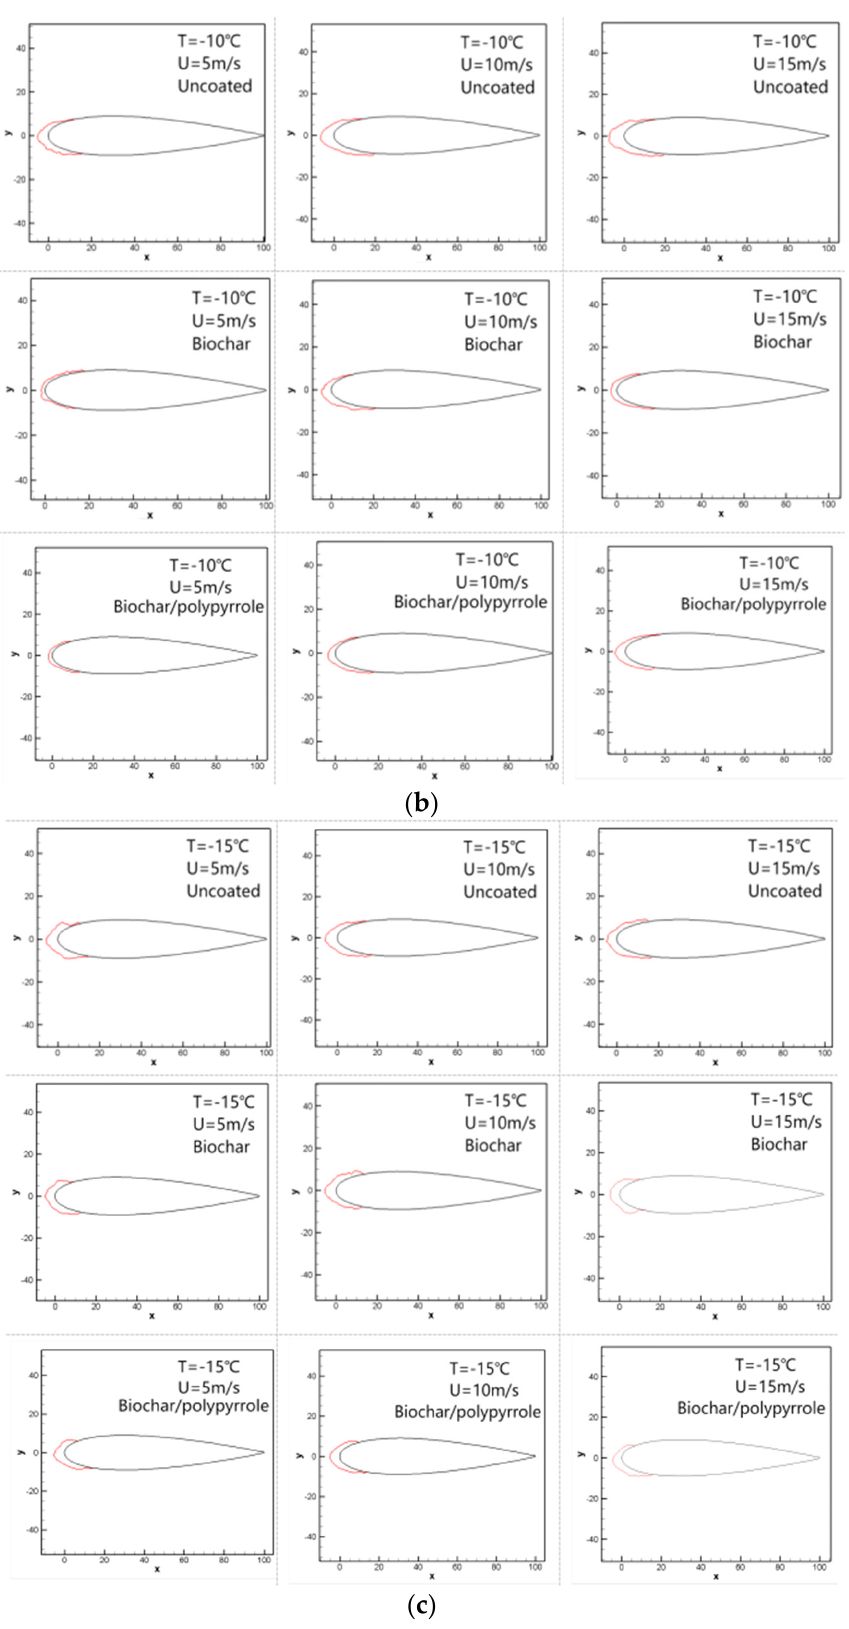
Figure 8. The maximum icing area of uncoated coating, biochar coating, and biochar/polypyrrole coating at ( a ) − 5 °C . ( b ) − 10 °C. ( c ) − 15 °C. coating at ( a ) − 5 ◦ C. ( b ) − 10 ◦ C. ( c ) − 15 ◦